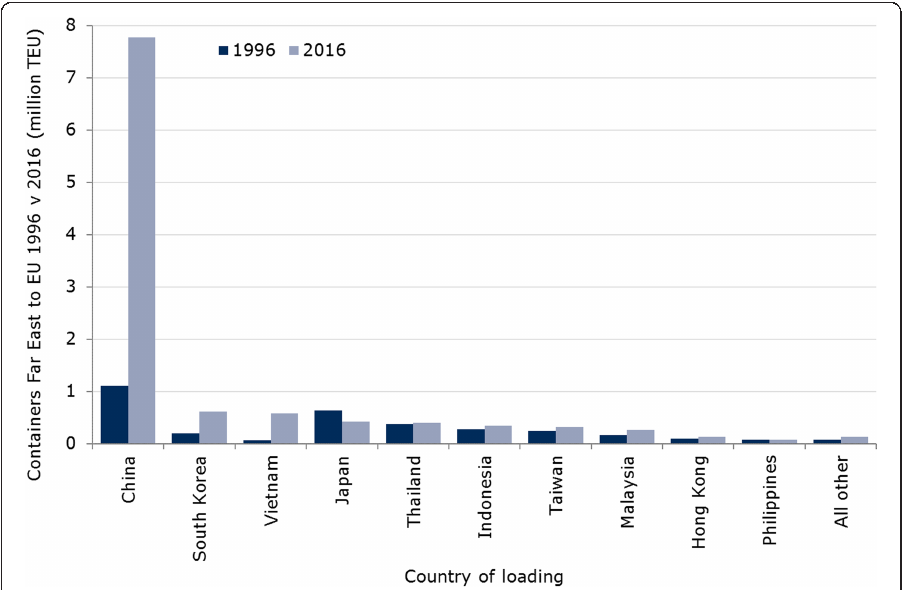
Fig. 2 Loaded containers from the Far East to Europe: country of loading (from Eurostat)